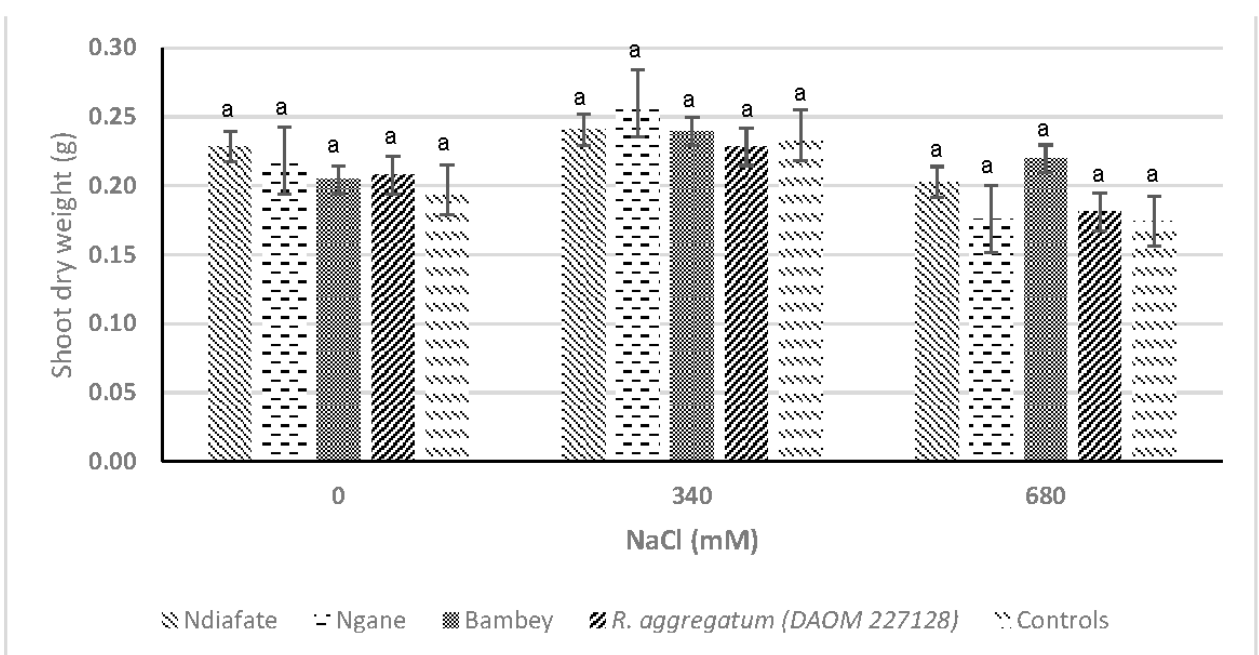
Figure 4. The effect of the AMF isolates × NaCl interaction on the dry biomass of the shoot parts of A. seyal seedlings after 30 days of culture. Ndiafate, Ngane, and Bambey correspond to high, moderate, and low salinity zones, respectively where the AMF were collected. Bars with the same letters for each variable are not significantly different at p < 0.05 (Newman–Keuls test) and error bars represent standard error of the mean ( n = 270).